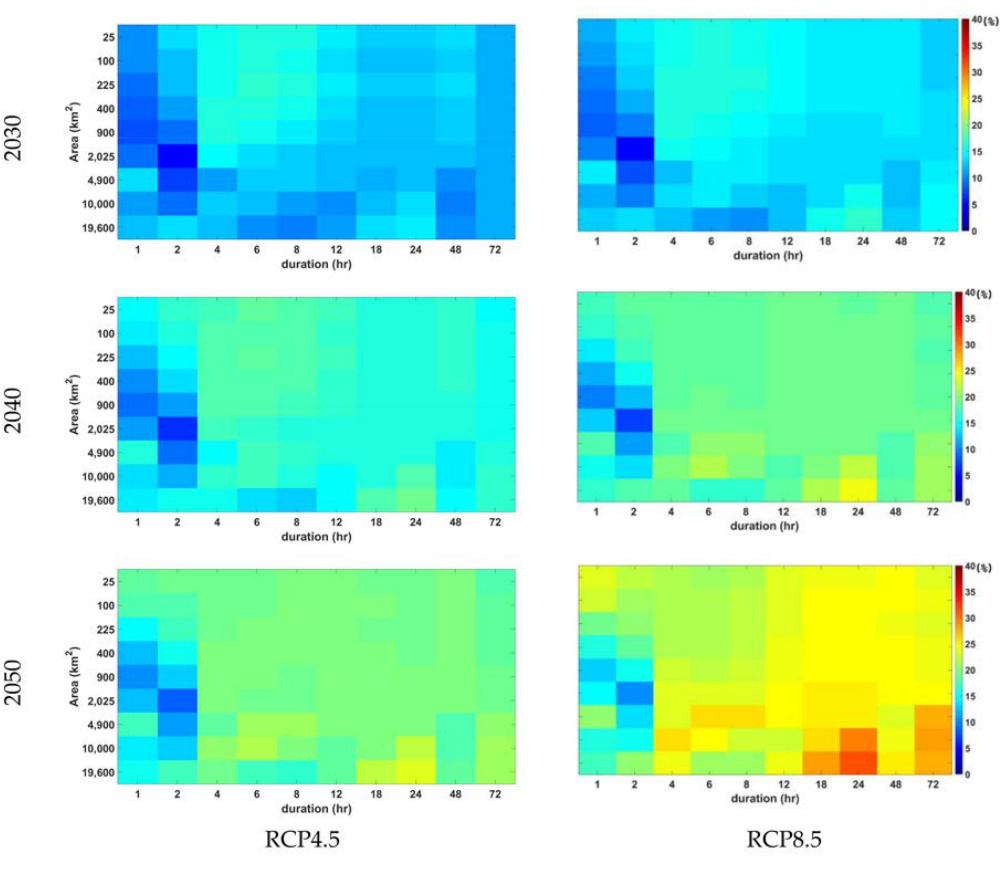
Figure 10. PMPs change rate (%) driven by Hadgem3-RA.